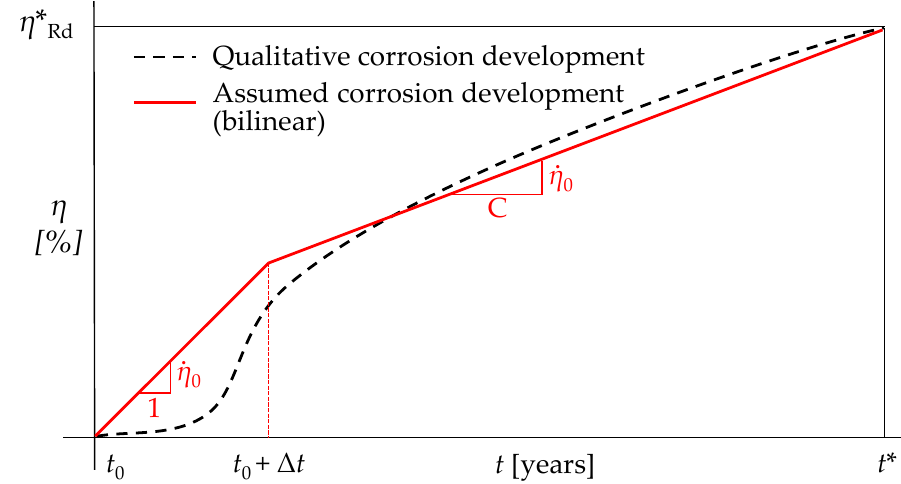
Figure 2. Qualitative (black dashed curve) and assumed (red solid polyline) trends for corrosion development for the proposed methodological approach.